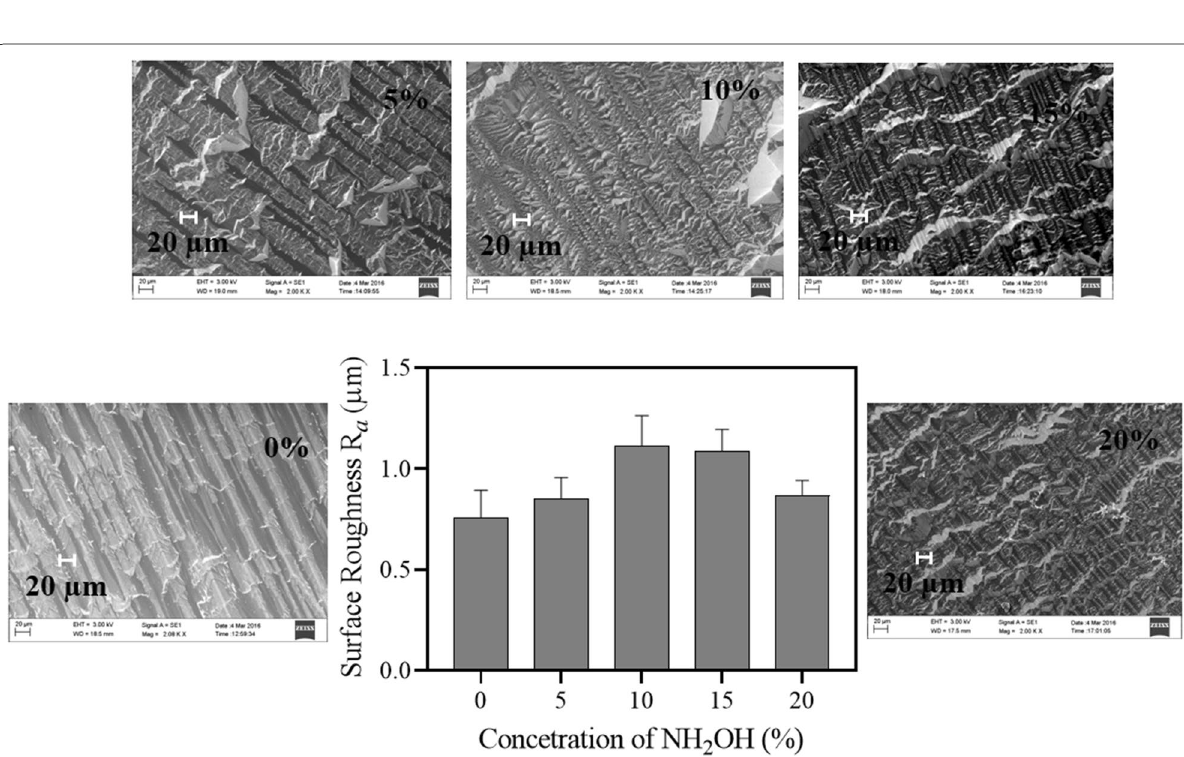
Fig. 43 Etched surface roughness (Ra) and corresponding surface morphologies of Si{110} in pure and different concentrations of NH 2 OH added 20 wt% KOH at 75 1 °C ±